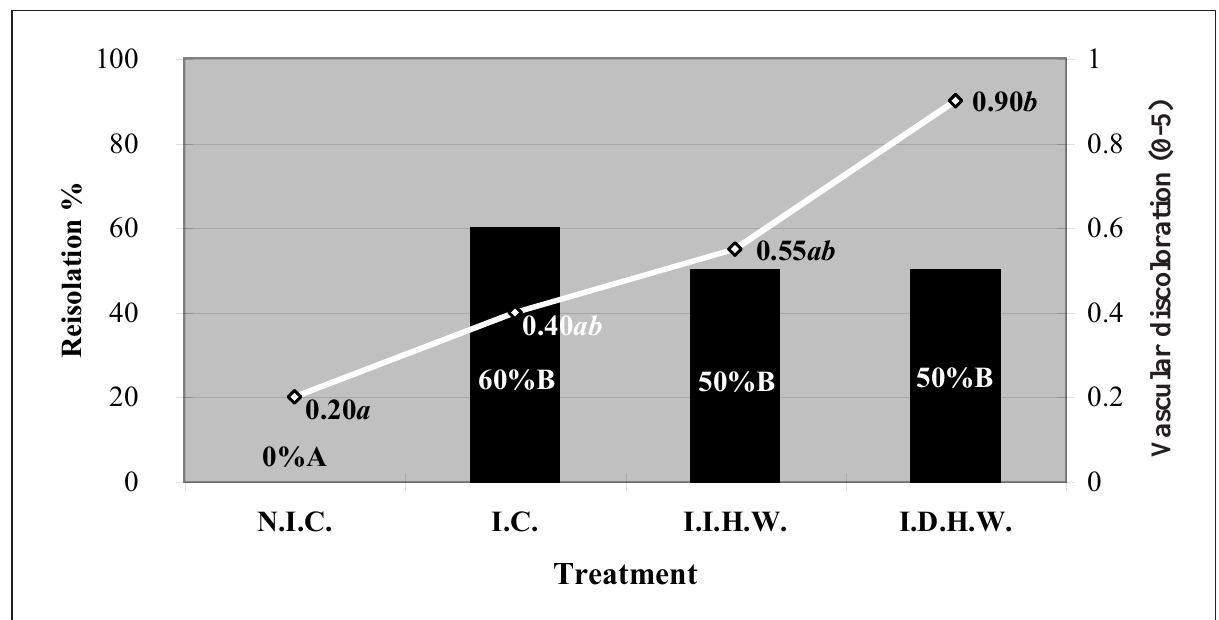
MediterraneaS.N. Fig. 2. Hot water treatment effect on colonization by Phaeoacremonium inflatipes (histogram) and vascular discol- oration (line) on artificially inoculated grapevines ( Vitis vinifera cv. Pinot noir). N.I.C., cuttings inoculated with sterile water only and not treated in hot water; I.C., cuttings inoculated with Pm. inflatipes and not treated in hot water; I.I.H.W., cuttings inoculated with Pm. inflatipes and immediately treated in hot water; I.D.H.W., cuttings inoculated with Pm. inflatipes and treated in hot water 24–48 hours later. Means followed by the same letter are not significantly by different according to Duncan’s Multiple Range Test ( P